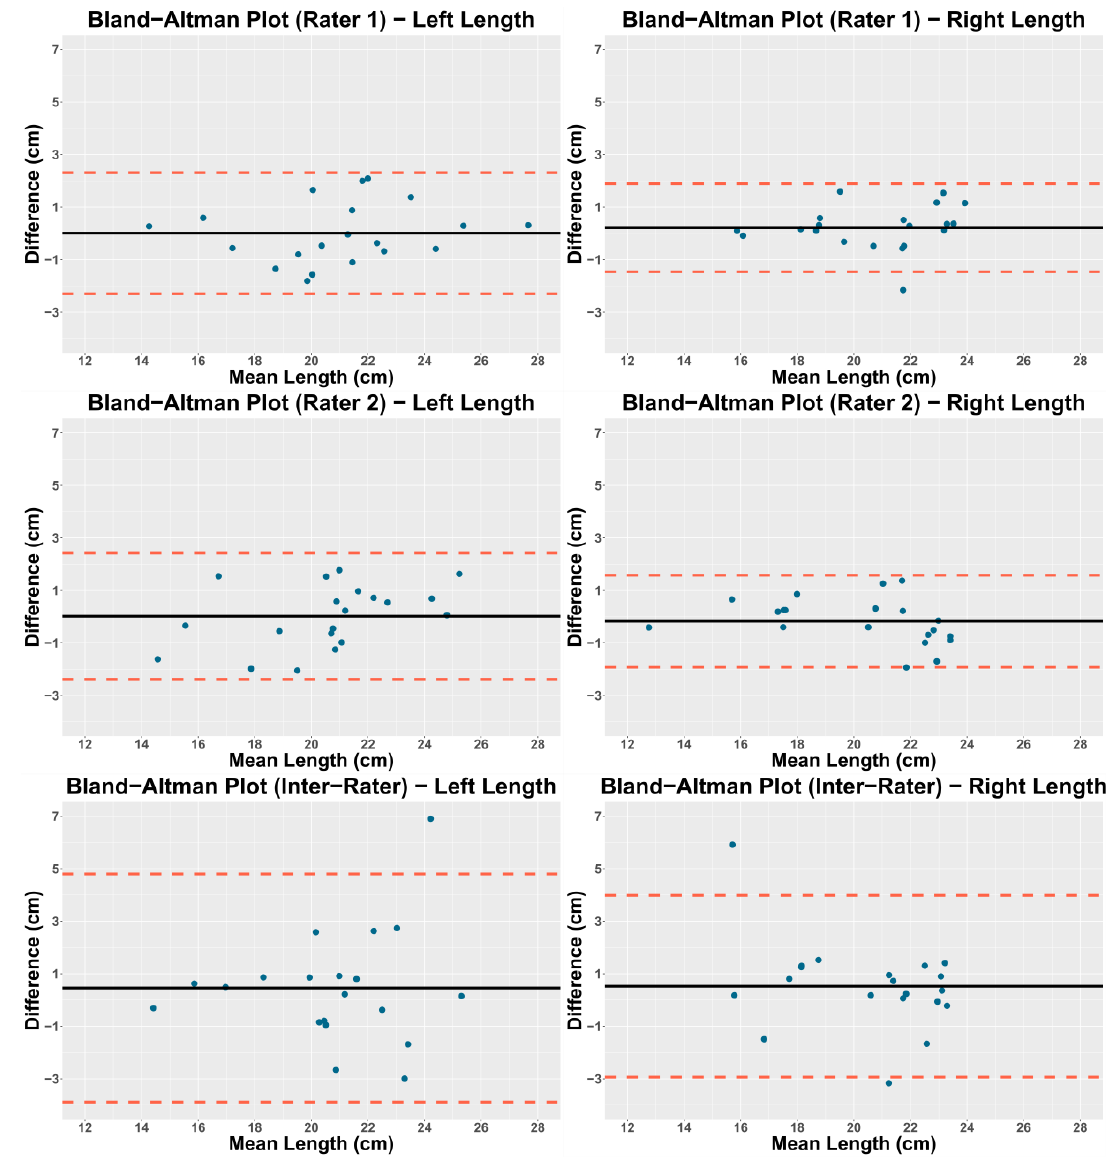
Figure 2. Bland-Altman plots.